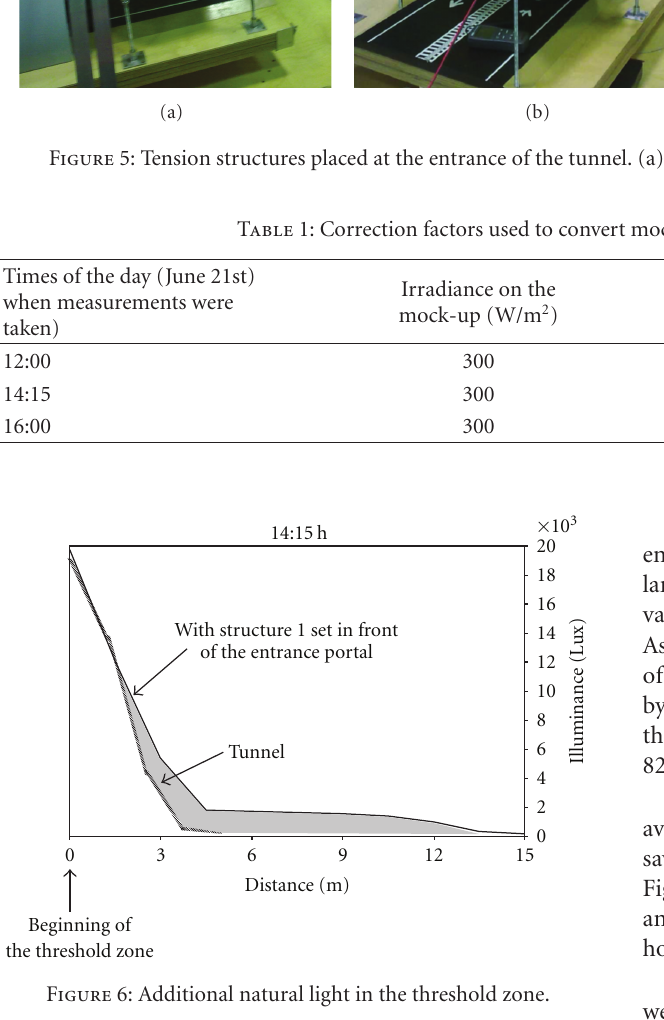
anchored and from which it extends to the centre of the